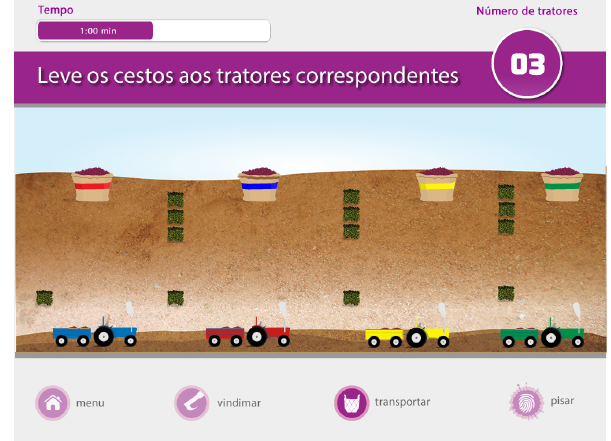
Fig. 3. Exercises scuity motor activities by